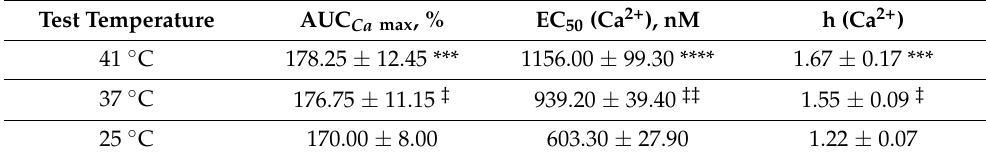
Table 4. Calculated values of AUC Ca max , EC 50 , and Hill coefficient (h) for 25 ◦ C, 37 ◦ C, 41 ◦